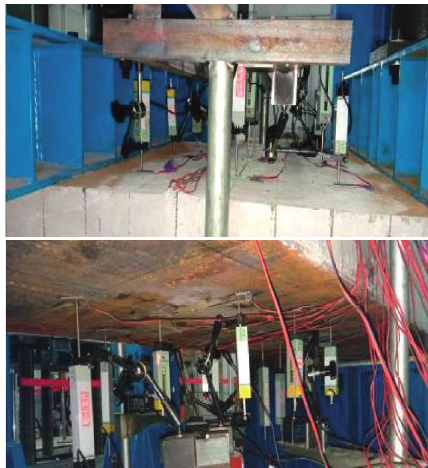
Figure 10: Field displacement meter arrangement of flexural